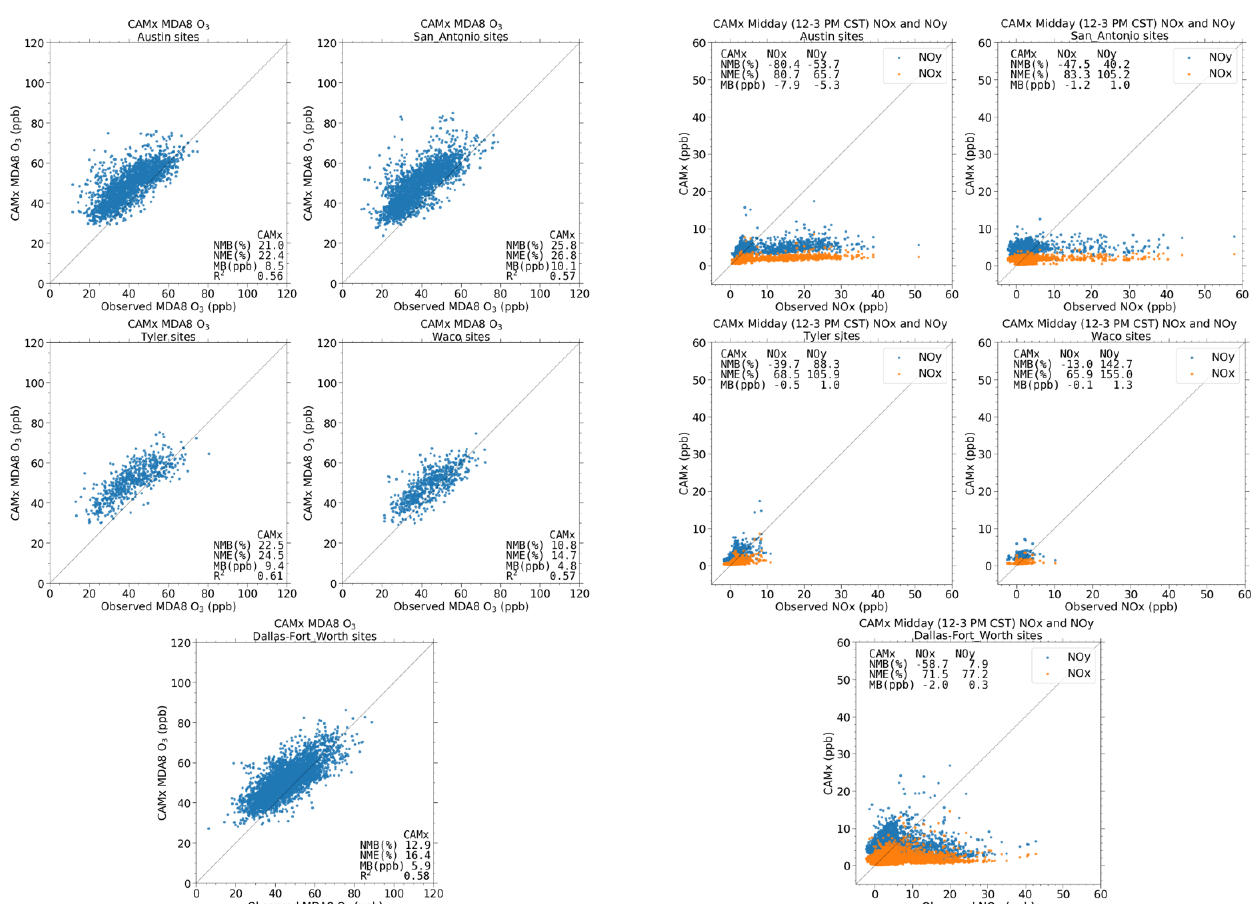
Figure A1. CAMx model performance for (left) maximum daily averaged 8h ozone (MDA8 O 3 ) and (right) midday 12:00–15:00LT (local time) NO x and NO y . The model output is compared to the EPA Air Quality System (AQS) ground observations for the five regions of interest in our eastern Texas domain (Austin, San Antonio, Tyler, Waco, and Dallas–Fort